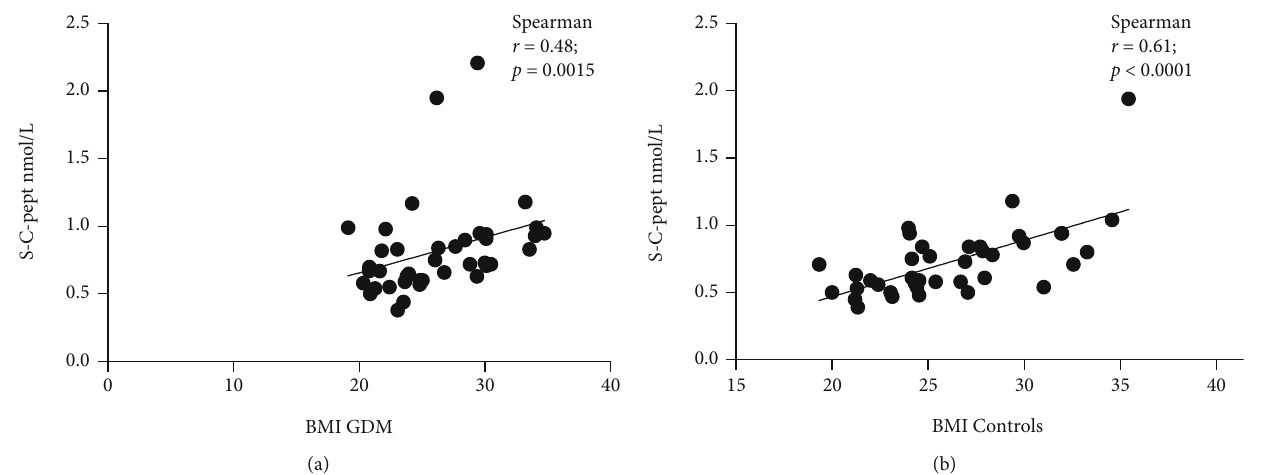
Figure 2: (a) Correlation between C-peptide level and BMI in GDM women. (b) Correlation between C-peptide level and BMI in controls.